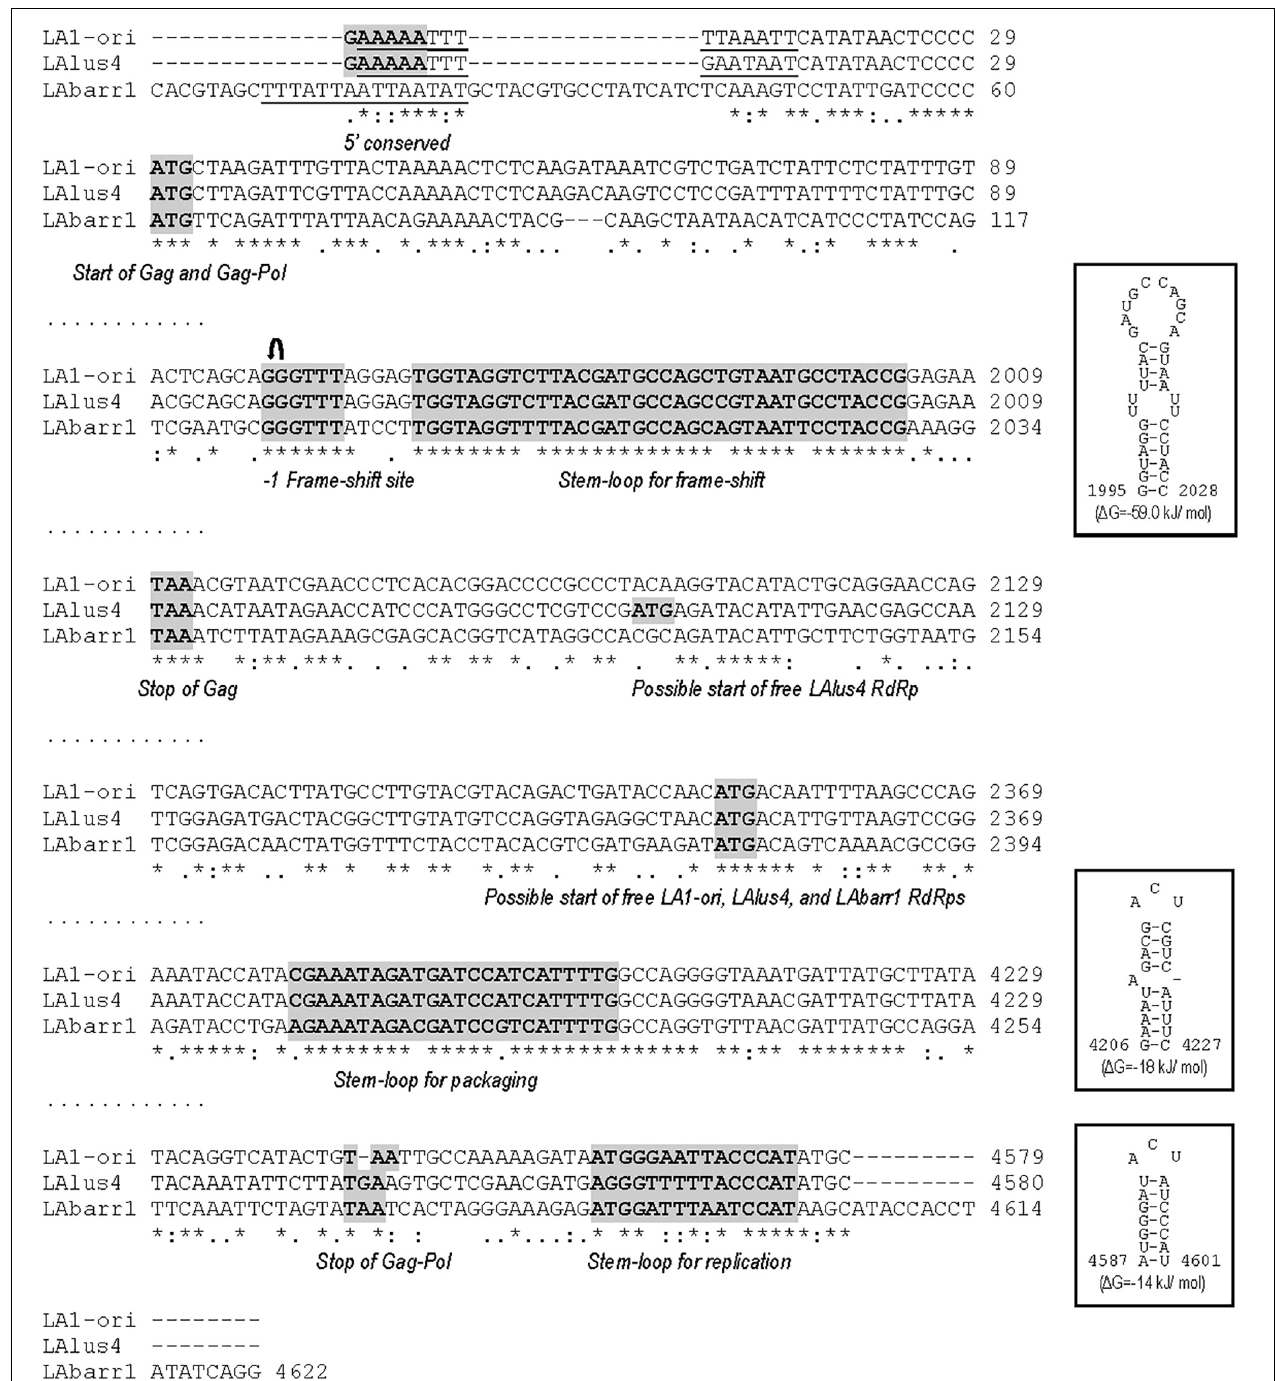
FIGURE 1 | Partial multiple sequence alignment between ScV-LA-original, ScV-LAlus4, and TdV-LAbarr1 (+) strand nucleotide sequences (cDNA). The full sequence alignment is presented in Supplementary Figure S1 . 5 (cid:48) GAAAAA conserved motif (5 (cid:48) conserved), translation initiation (start of Gag and Gag-Pol, or internal ATG in Pol ORF of ScV-LA-original, ScV-LAlus4, and TdV-LAbarr1) and termination (stop of Gag or Gag-Pol) codons, ribosome frameshifting site ( − 1 frameshift site), frameshifting associated sequence (stem loop for frameshift), packaging signal (stem loop for packaging), and replication signal (stem loop for replication) are indicated and gray shaded in the nucleotide sequence. An AU-rich 15-nucleotide stretch located in the 5 (cid:48) untranslated terminal region is underlined. , ribosomal frameshift. Asterisks (*), colons (:), and dots (.) indicate identical nucleotide positions, transitions, and transversions, respectively. The secondary structures of the putative cis signals for frameshifting, packaging, and replication of TdV-LAbarr1 are displayed at the right of the sequence panel.